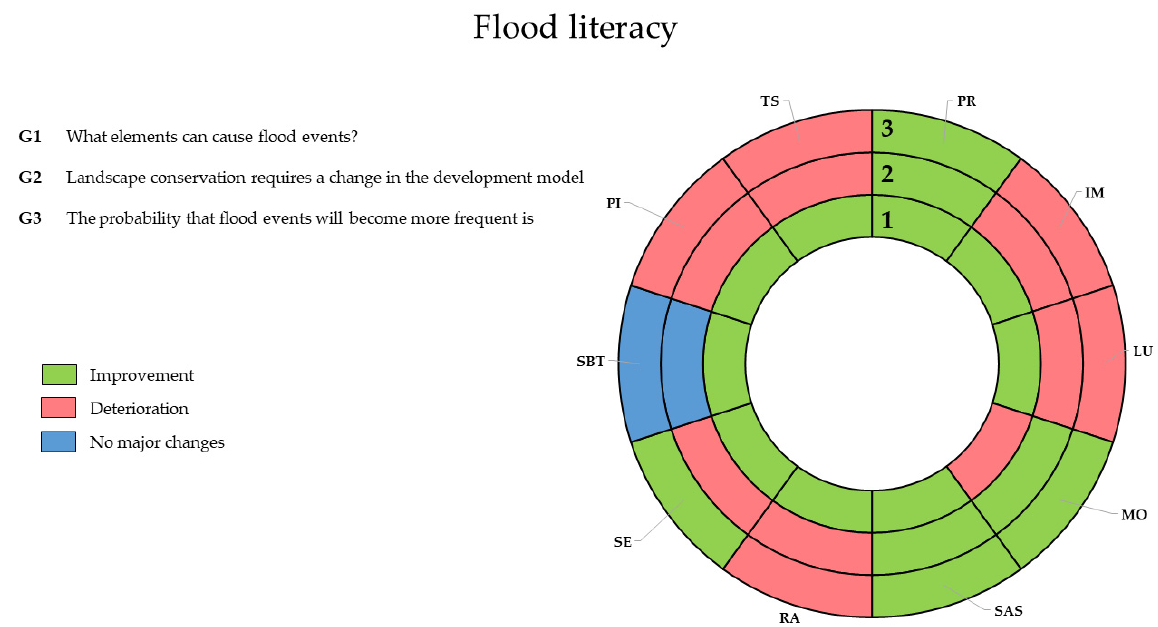
Figure 2. Representation of the effect of the LIFE PRIME project activities in shaping flood literacy in the ten pilot areas (PR = Poggio Renatico; IM = Imola; LU = Lugo; MO = Mordano; SAS = Sant’Agata sul Santerno; RA = Ravenna; SE = Senigallia; SBT = San Benedetto del Tronto; PI = Pineto; TS = Torino di Sangro). Each question is represented as a circle numbered from G1 to G3 and colors represent the increase (green), decrease (pink), or absence of a change (blue) in flood literacy between the ex-ante and ex-post phases.